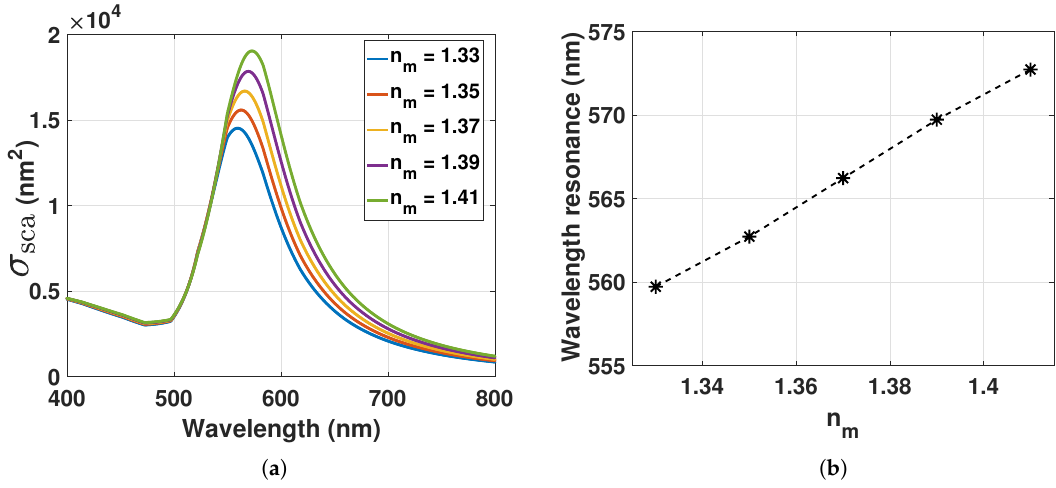
Figure 2. ( a ) Scattering cross-section computed from Equation (1) with L = 1 of GNP with 80 nm in diameter for increasing refractive index (RI) of the surrounding medium; ( b ) LSPR peak position from Figure 2a as a function of increasing